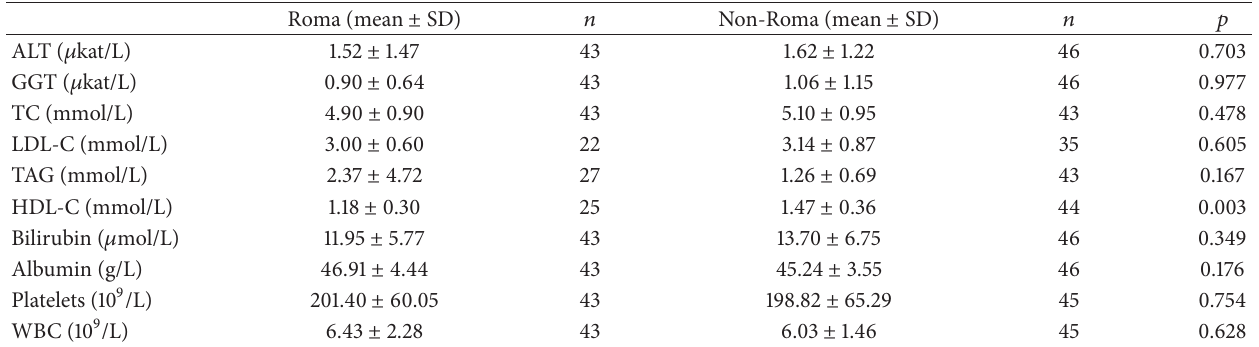
Table 2: Baseline biochemical and hematological parameters of the study cohort.